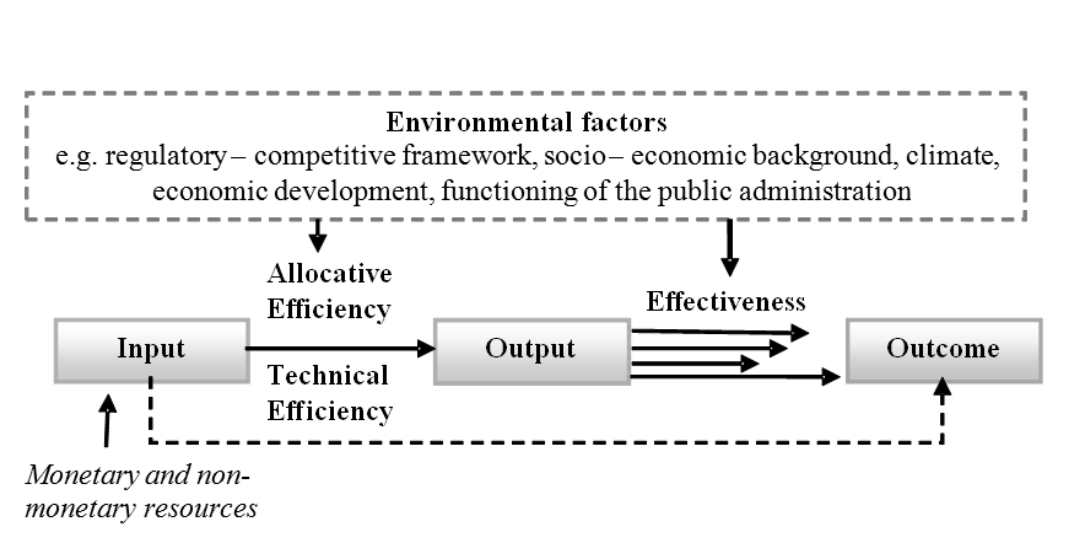
Figure 1 – Conceptual framework of efficiency and effectiveness (Mandl, Dierx, Ilzkovitz,